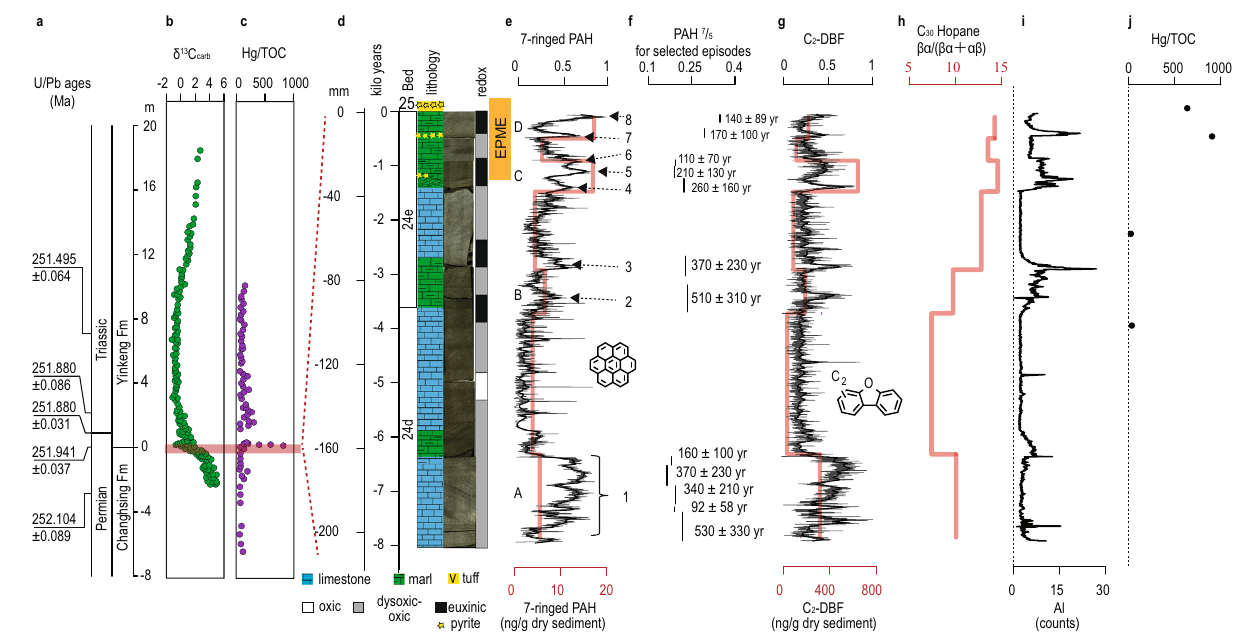
Fig. 2 | Abrupt environmental deterioration leading to the end-Permian mass extinction: chemostratigraphy of molecular biomarkers and aluminum abundances from the Meishan section, South China. a – c A stratigraphic record ( − 8 to 20m) of U/Pb ages 8 ( a ), stable carbon isotopic composition of carbonate 18 ( b )asagaugeofthecarboncycleandHg/TOCratio 18 ( c )representingvolcanogenic Hgconcentratedinterrestrialecosystems. d – j Anexpandedstratigraphicrecordof the top 200mm below the base of Bed 25 (0m) for the lithological column with ages and redox conditions based on framboidal pyrite data 39 ( d ), 7-ringed PAH ( e ) as a combustion marker, PAH 7 / 5 ( f ) as a combustion temperature marker, C 2 -DBF ( g ) and C 30 hopane βα /( βα + αβ ) ( h ) as markers for soil input, aluminum (relative abundance)( i )asamarkerforclasticinput,andtheHg/TOCratio( j ).In d ,thelinear